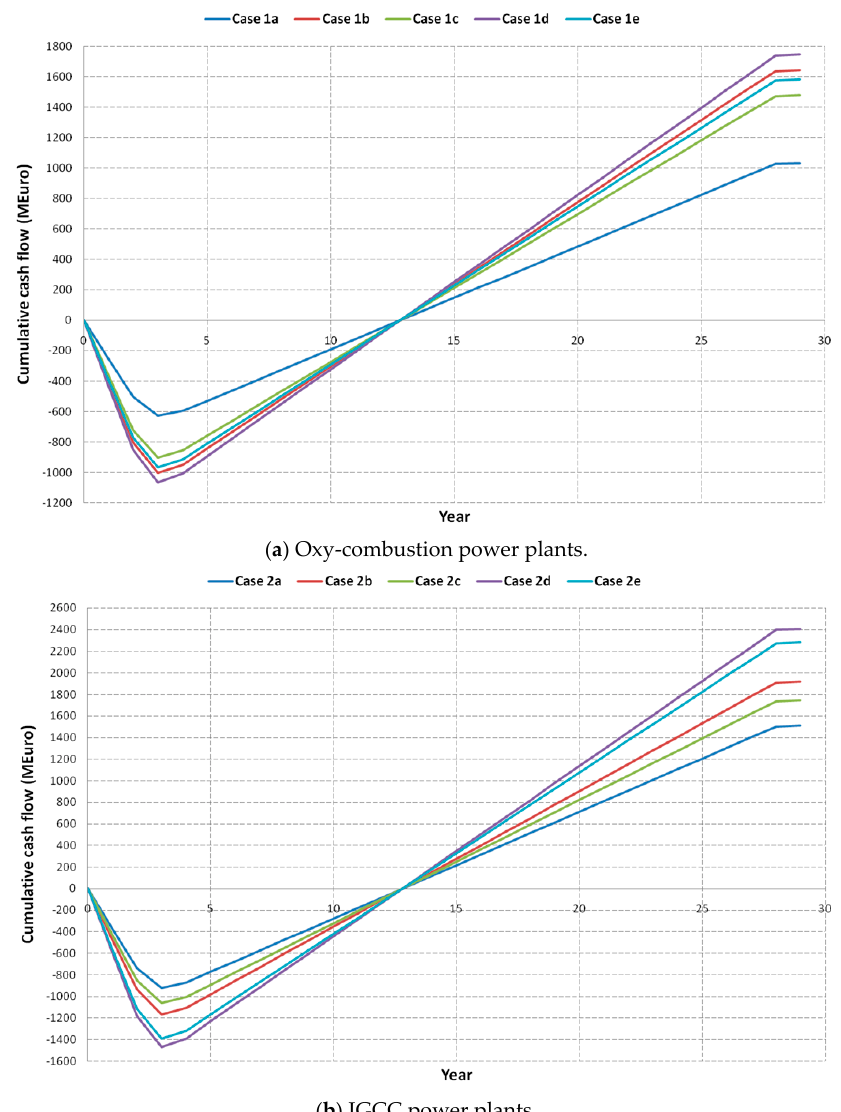
Figure 7. Cumulative cash flow analysis for oxy-combustion and IGCC power plants.